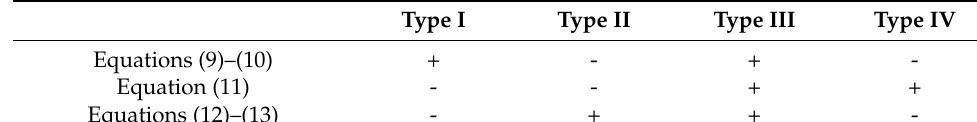
Table 1. Atypical ‐ bend collision ‐ model symbol comparison. Table 1. Atypical-bend collision-model symbol comparison.